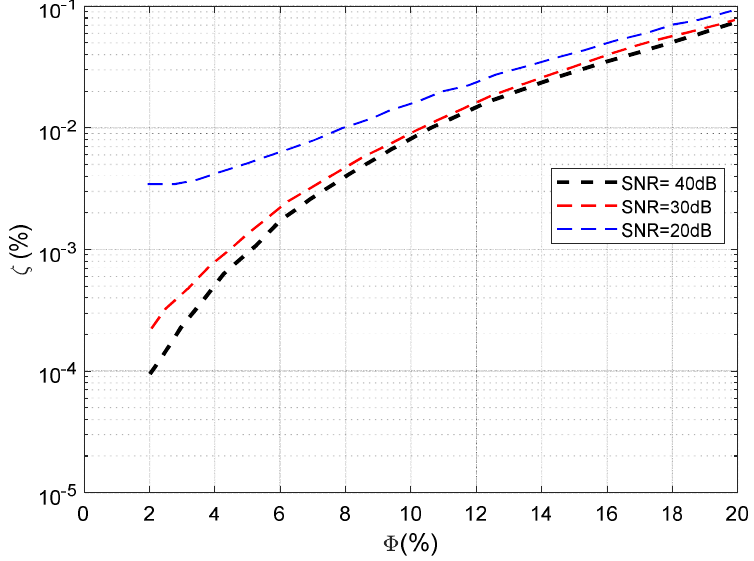
Figure 7. Detection index against failure rate for various SNRs.